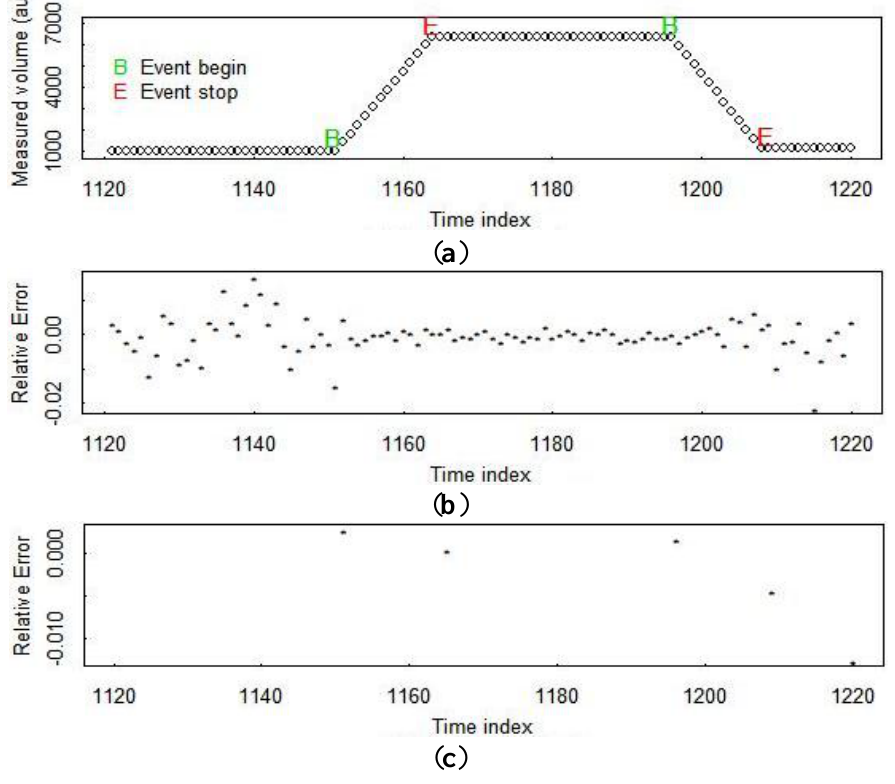
Figure 3. ( a ) The measured volume in a tank during a receive, wait, ship cycle; ( b ) PM residuals for bulk volume using option 1 PM; ( c ) PM residuals for bulk volume using option 2 PM. In PM option 1, residuals are generated on a fixed time schedule. In PM option